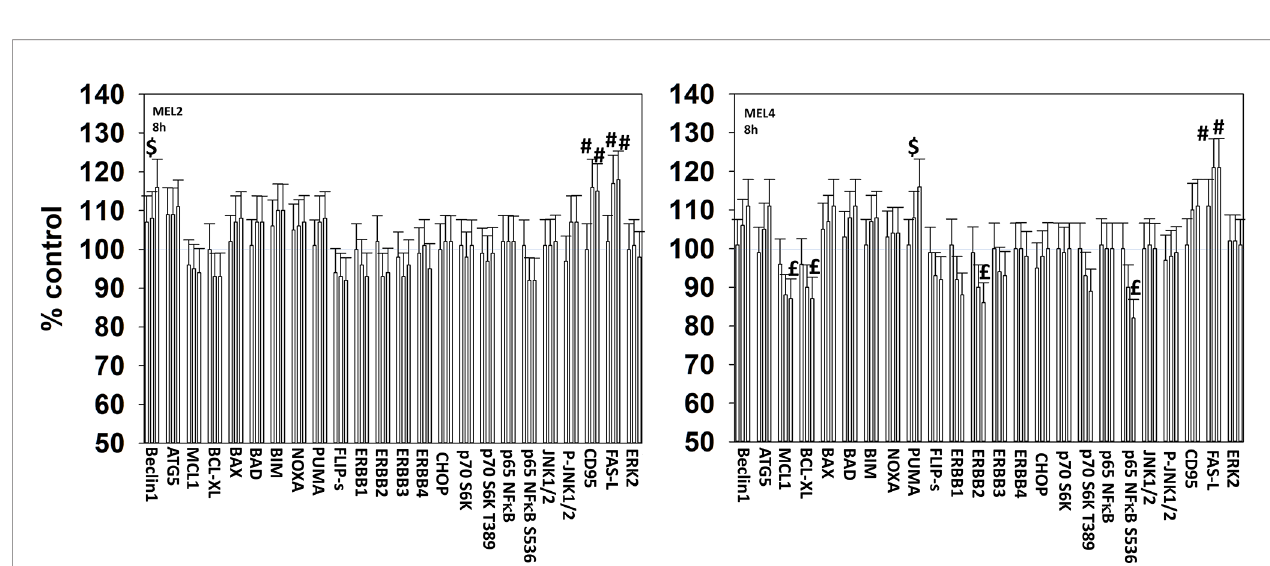
FIGURE 6 | Exposure to [GZ17-6.02 + trametinib + dabrafenib] has the potential to increase the expression of ATG5 or reduce MCL1 and BCL-XL levels. Melanoma cells were treated with vehicle control, GZ17-6.02 [curcumin (2 µM) + isovanillin (37.2 µM) + harmine (4.5 µM)], [trametinib (2 µM) + dabrafenib (2 µM)] or the drugs in combination for 8h. (the three bars per protein from left to right are trametinib/dabrafenib, GZ17-6.02 and the drugs combined). Cells were fi xed in place and in-cell immunostaining performed to determine the expression and the phosphorylation of the indicated proteins (n = 3 +/-SD) *p < 0.05 less than vehicle control; £ p < 0.05 less than either drug as a single agent; # p < 0.05 greater than vehicle control; $ p < 0.05 greater than either drug as a single agent.